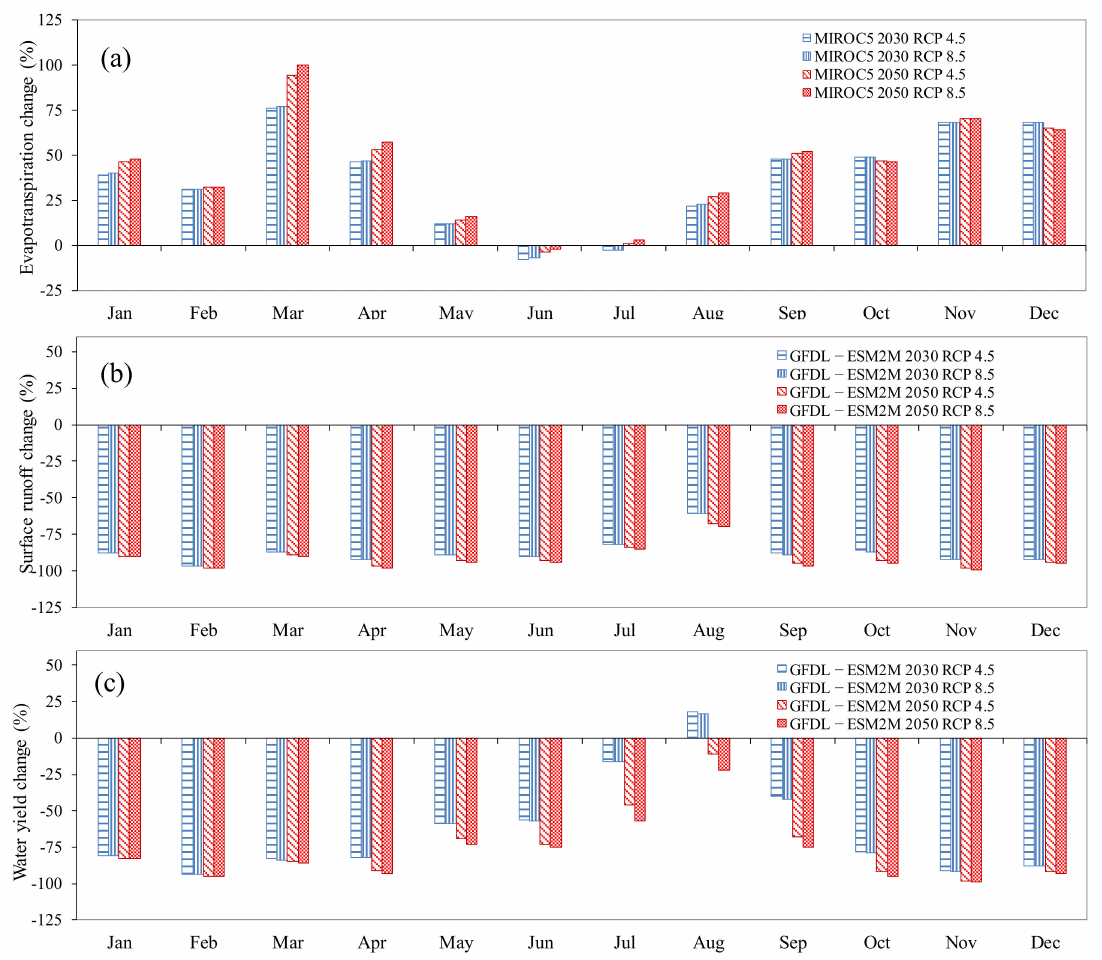
Figure 6. Changes of monthly ( a ) evapotranspiration, ( b ) surface runoff, and ( c ) water yield in 2030 and 2050 under the scenarios of RCP4.5 and